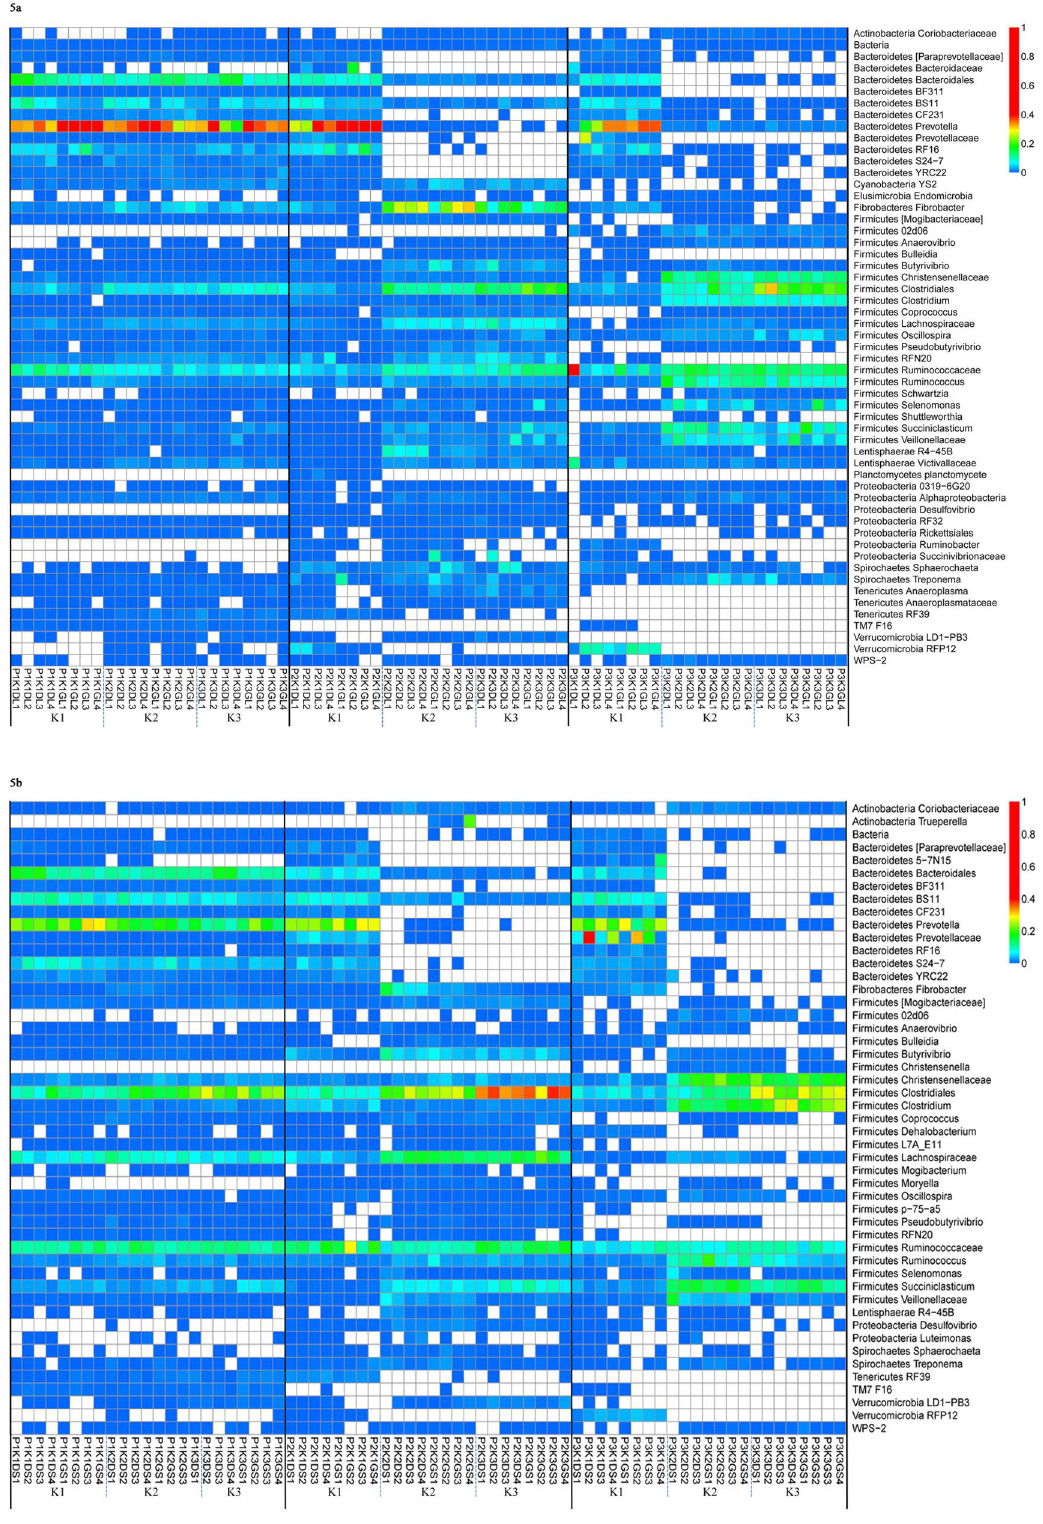
Figure 5. Thermal double dendrogram of the most abundant bacterial operational taxonomic units (OTUs). Rumen fraction a) liquid; b) solid; Primer pair (P1: targeting V1–V3 region; P2: targeting V4–V5 region and P3: targeting V6–V8 region), treatment: (DK1: 50% dry forage: 50% concentrate; DK2: 75% dry forage: 25% concentrate and DK3: 100% dry forage; GK1: 50% green forage: 50% concentrate; GK2: 75% green forage: 25% concentrate; GK3: 100% green forage).